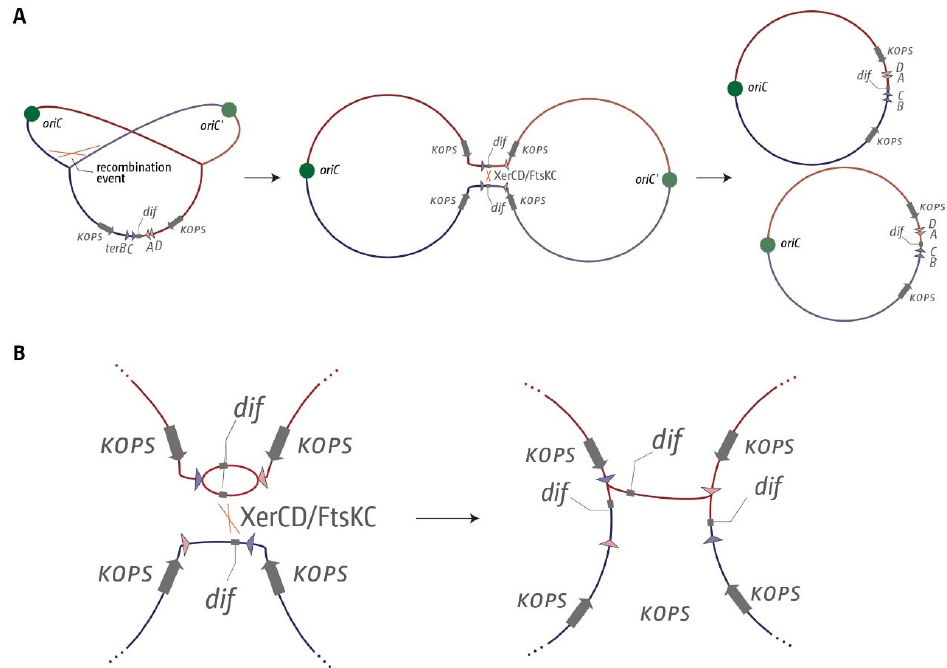
Figure 9. Dimer resolution of circular chromosomes. ( A ) Circular E. coli chromosome that is in the process of being replicated. Only the innermost ter sites A , B , C and D are shown. The general orientation of the KOPS sequences that allow directional travel of the FtsK protein are shown by grey arrows with the label ‘KOPS’. An odd number of recombination events can result in the formation of chromosomal dimers. If a chromosomal dimer is formed, the XerCD site-specific recombinase allows for a recombination event between the two dif sites, which results in the resolution of the chromosomal dimer. ( B ) If the termination area, including dif , is over-replicated in one of the two chromosomes, a recombination event between two of the dif sites will not result in full resolution of the chromosomal dimers. See main text for